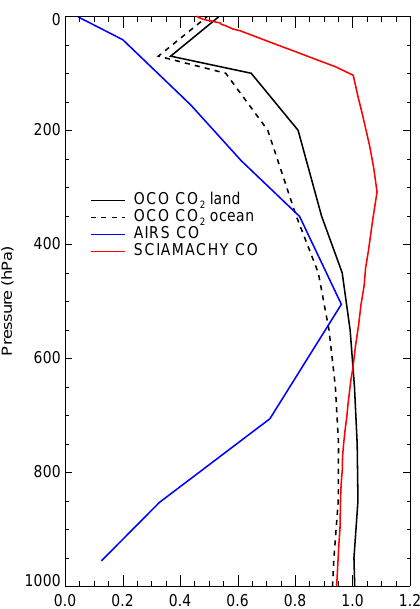
Fig. 1. Typical column averaging kernels for OCO retrieving CO 2 and for SCIAMACHY and AIRS retrieving CO. OCO kernels are for conifer and ocean surfaces with solar zenith angle of 20 ◦ and optical depth of 0.005 (Bosch et al., 2008). The AIRS kernel is for a clear-sky ocean scene at 2.2 ◦ N and 156.9 ◦ W on 1 August 2006 (http://disc.sci.gsfc.nasa.gov/AIRS). The SCIAMACHY kernel is for a solar zenith angle of 20 ◦ (Buchwitz et al., 2004).